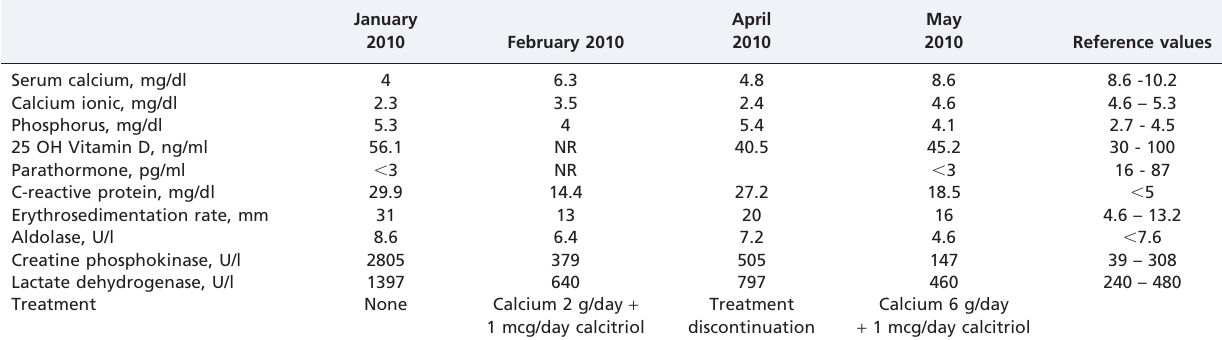
Table 1 - Laboratory data and treatment.